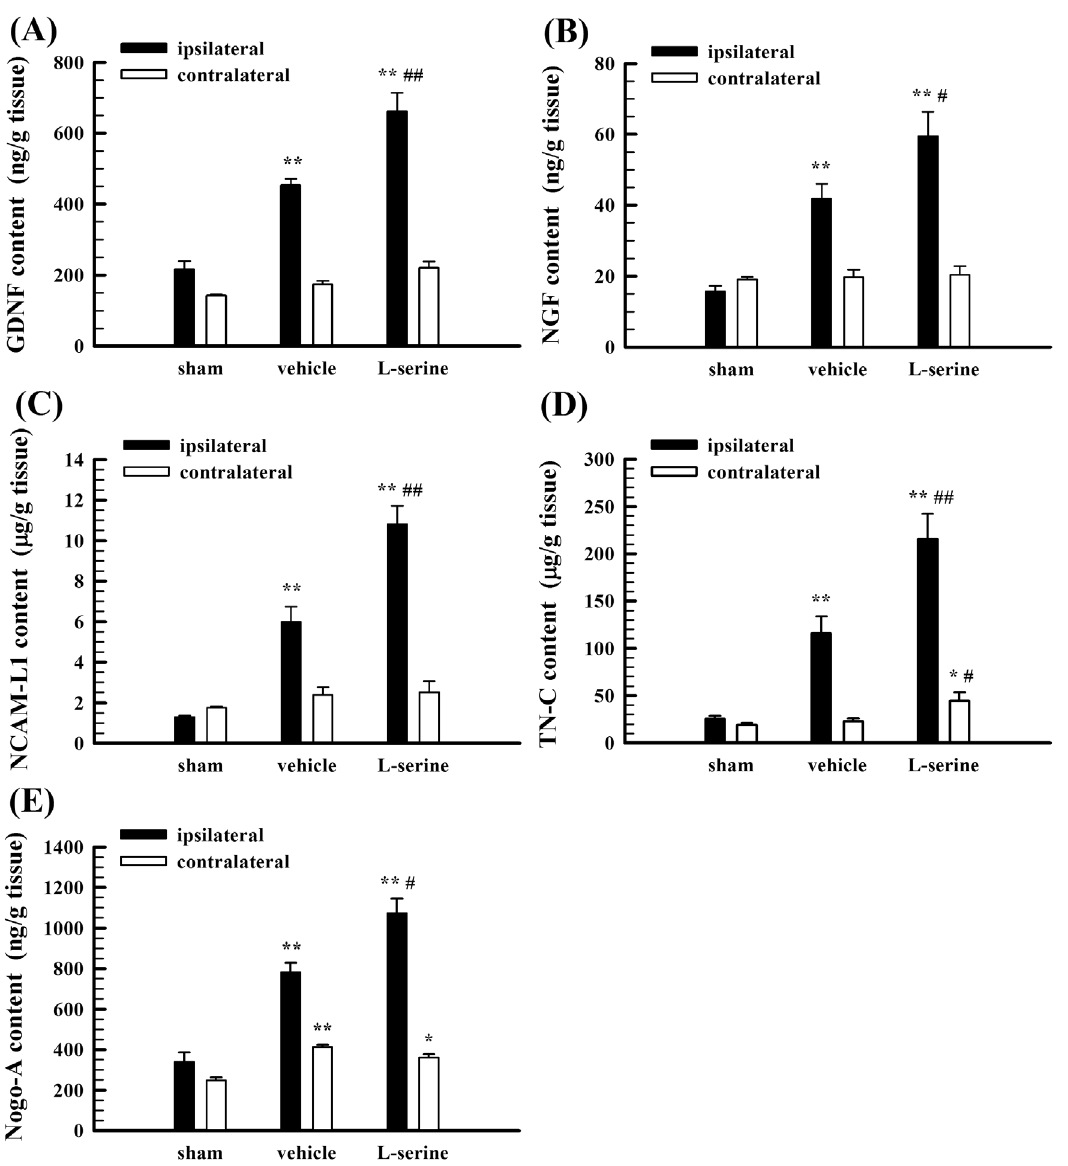
Figure 5. Effect of L-serine treatment on the expression of nerve growth-related factors in both sides of the brain tissue in rats 5 days after pMCAO (n=6). (A) Changes in the expression of GDNF in different groups. (B) Changes in the expression of NGF. (C) Changes in the expression of NCAM L1. (D) Changes in the expression of TN-C. (E) Changes in the expression of Nogo-A. * p , 0.05, ** p , 0.01 vs . sham-operated group; # p , 0.05, ## p , 0.01 vs . vehicle